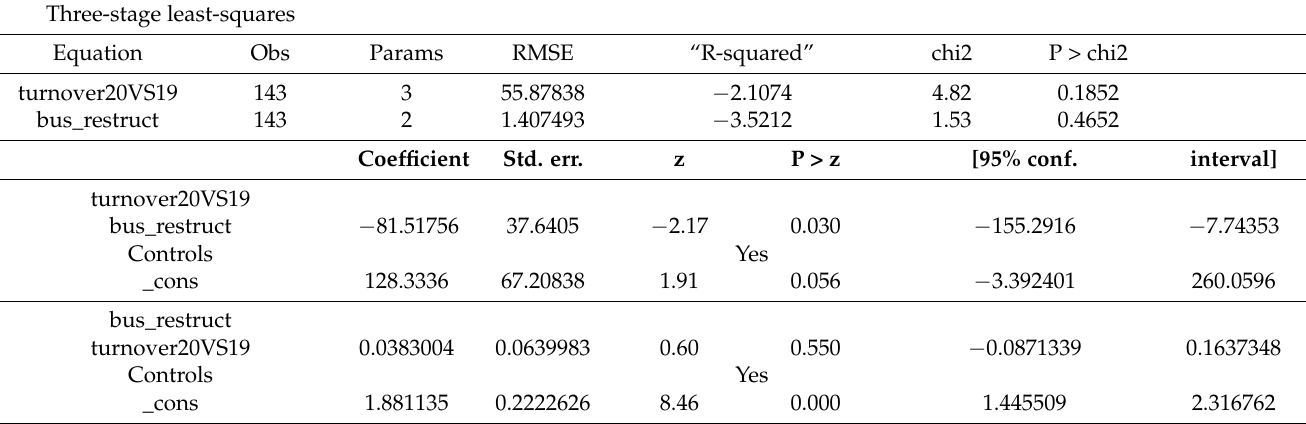
Table 13. Regression results with simultaneous